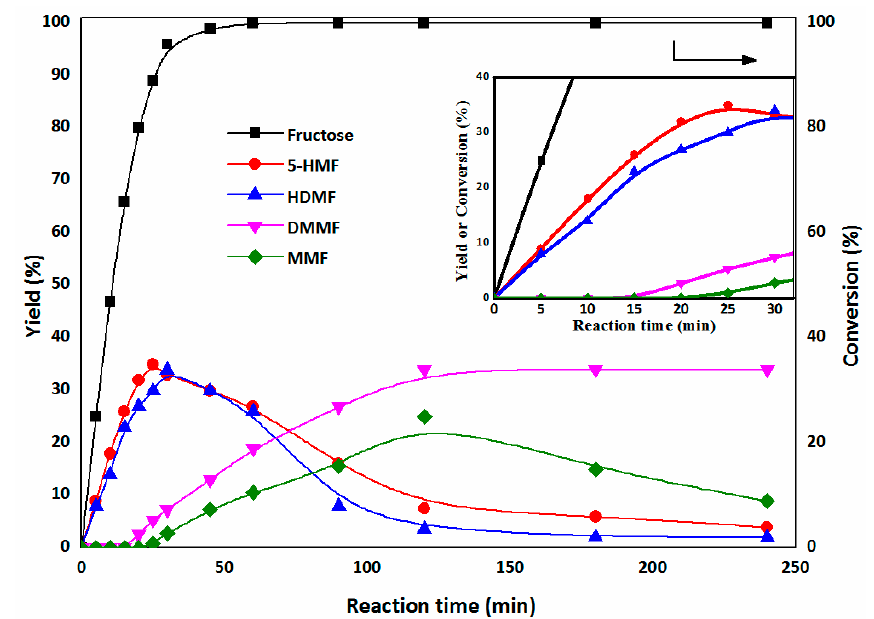
Figure 4. Effect of reaction time on the reaction. Reaction conditions: 150 °C, 1.37 mmol fructose, 50 mg SiO 2 ‐ HNO 3 , 4.0 mL solvent (DMSO/methanol 30/70 v / v ). (Inset: details for 5 ‐ HMF, HDMF, DMMF, and MMF for the first 30 min of the reaction).